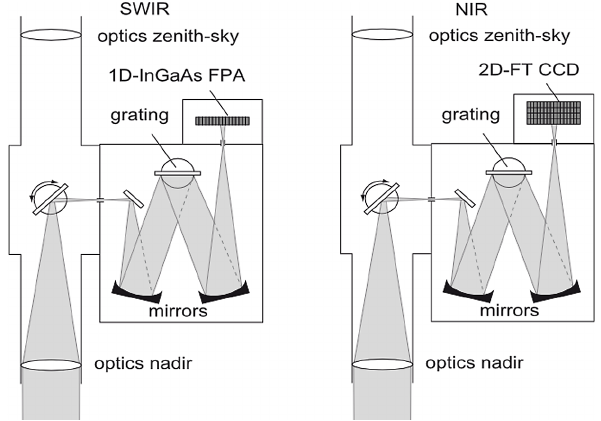
Fig. 1. Sketch of the MAMAP SWIR and NIR spectrometer mod- ules. Both spectrometers have two separate light intake telescopes pointing towards nadir and zenith-sky directions for measurements of nadir and zenith radiances. A mirror enables switching between both modes. For zenith irradiance measurements zenith optics can be equipped optionally with glass fibers and transmissive diffuser optical inlets (not shown in this